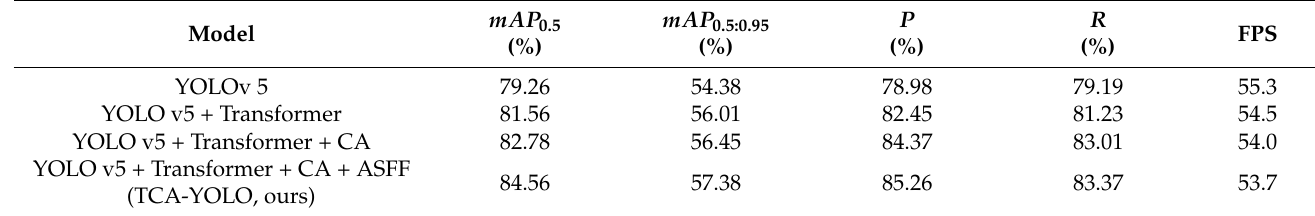
Table 1. Results of the experiment.